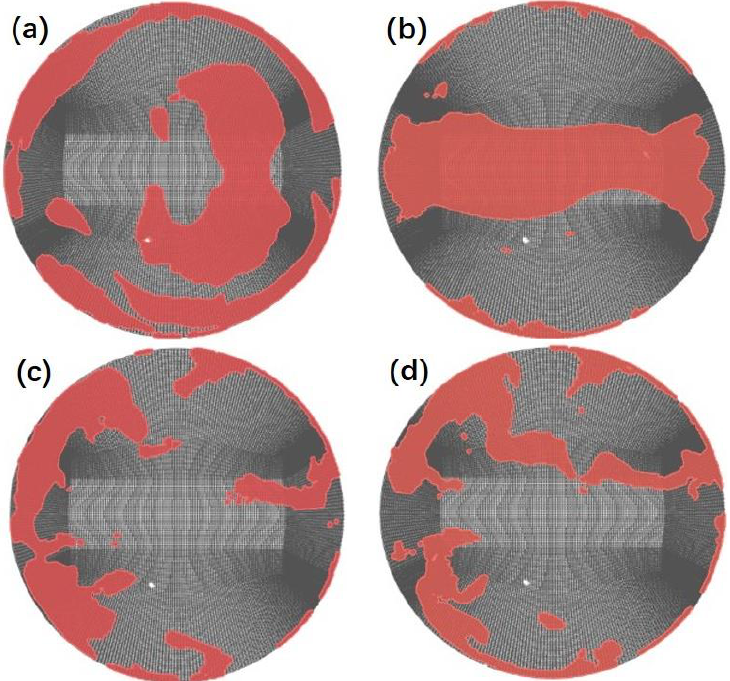
Figure 9. Schematics of solidified meshes along the cross-section at half of the height of the mixture when stood for ( a ) 0 s, ( b ) 0.5 s, ( c ) 1.0 s and ( d ) 1.2 s.